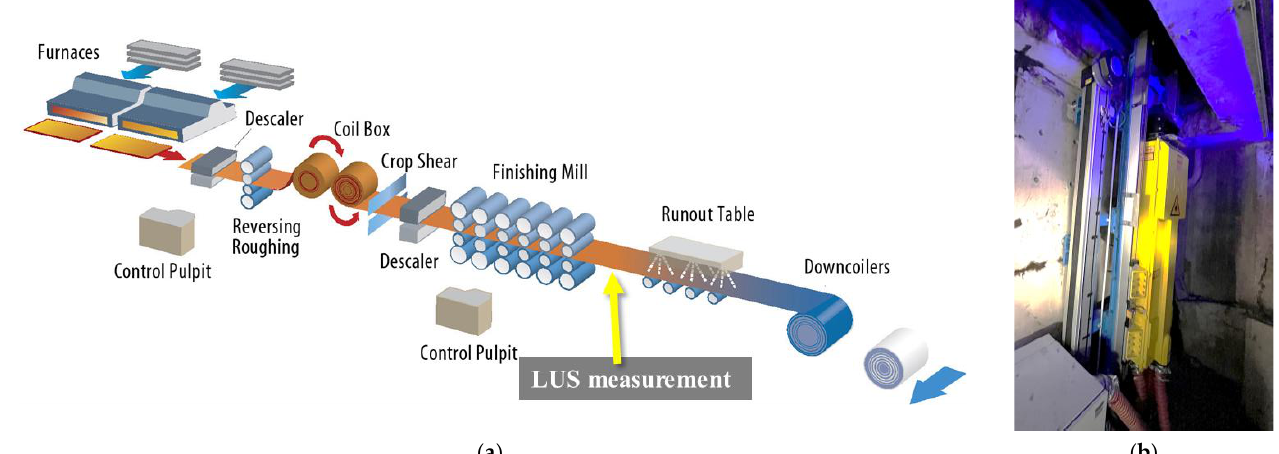
Figure 4. ( a ) Illustration of the hot strip mill in Borlänge, Sweden. The different components are denoted from the reheating furnaces on the left to the downcoilers on the right. The position of the new LUS grain size gauge is marked by the yellow arrow just before the runout table. ( b ) Image of the LUS grain size gauge, produced by EMG Automation GmbH.